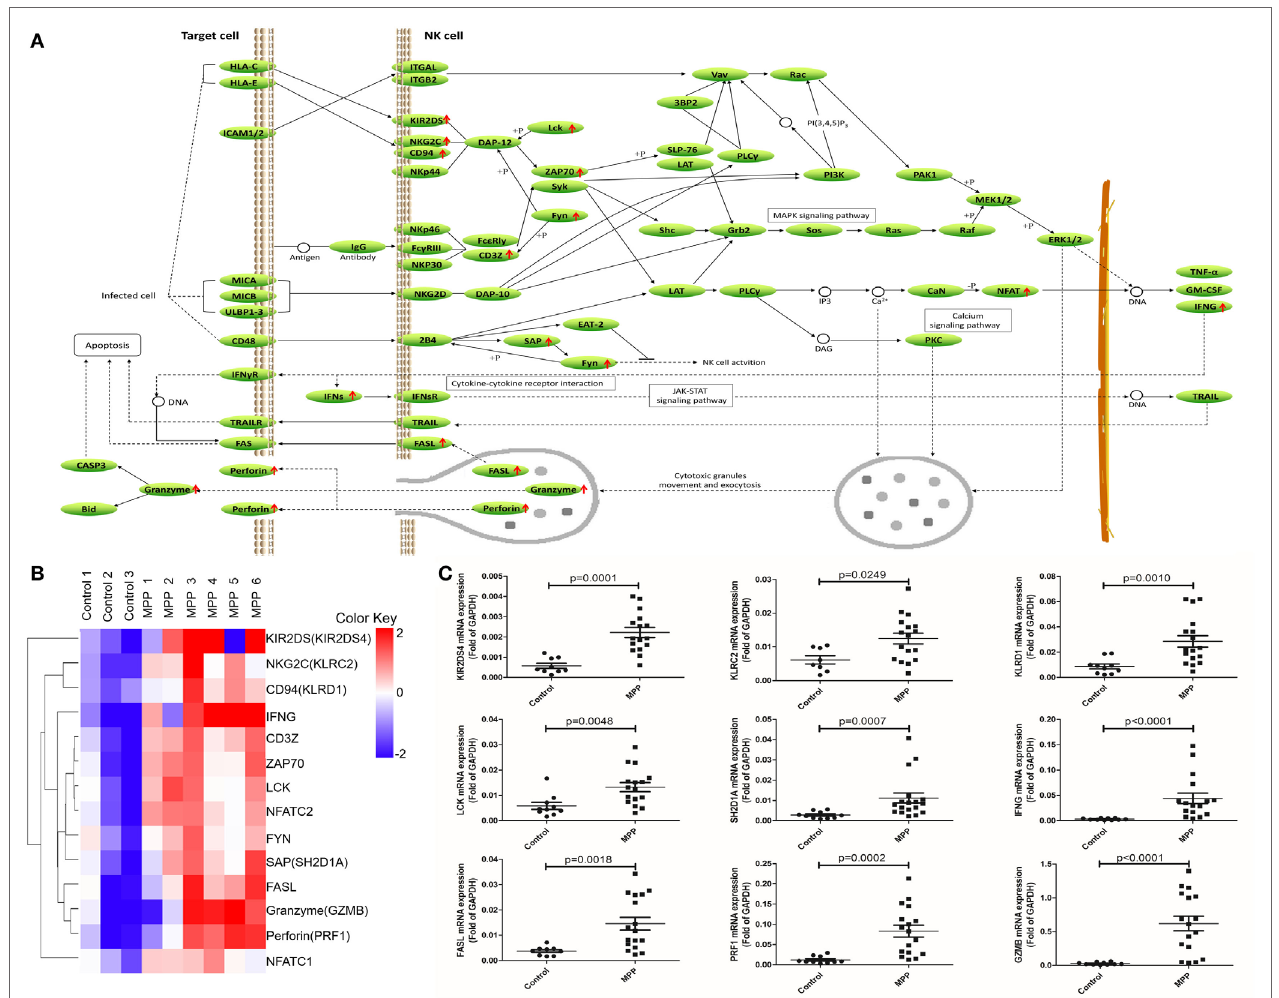
FigUre 5 | Differential expression genes (DEGs) mapped to natural killer (NK) cell-mediated cytotoxicity Kyoto encyclopedia of genes and genomes pathway. (a) Model diagram showing NK cell-mediated cytotoxicity pathway, red arrows indicate upregulated gene expression. (B) Cluster analysis of DEGs that mapped to NK cell-mediated cytotoxicity pathway. (c) Quantitative real-time PCR validation of DEGs mapped to NK cell-mediated cytotoxicity